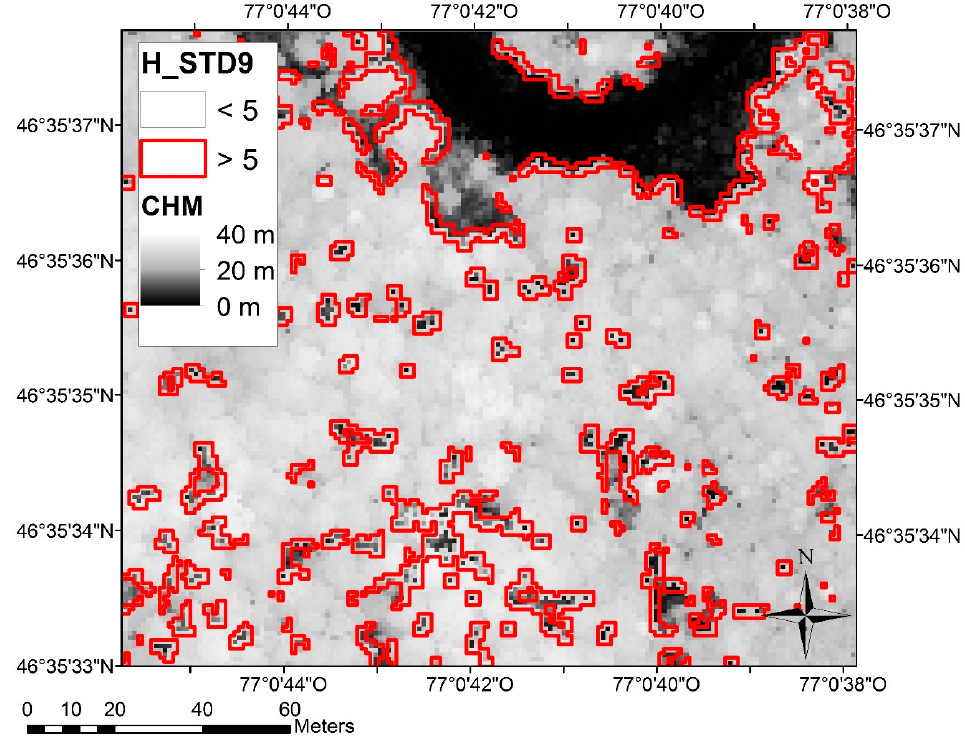
Figure 4. H_STD9 values of more than five for a low density LiDAR survey overlaid on a CHM.